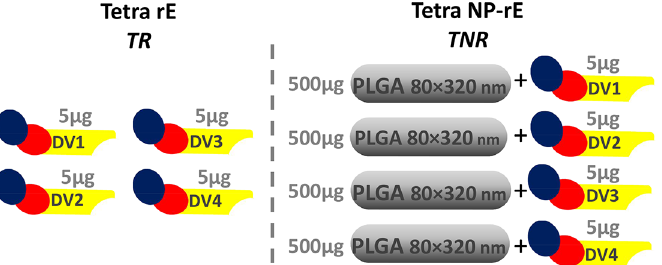
Fig 4. Tetravalent DENV1-4 rE formulations. The tetravalent formulations were divided into 2 groups. The tetra rE group (TR) combined 5 μg soluble rE of each serotype (n = 5). The tetra NP-rE group (TNR) combines four individually adsorbed NP-rE formulations of each DENV serotype (NP-rE DENV1 + NP-rE DENV2 + NP-rE DENV3 + NP- rE DENV4 (500 μg NPs + 5 μg